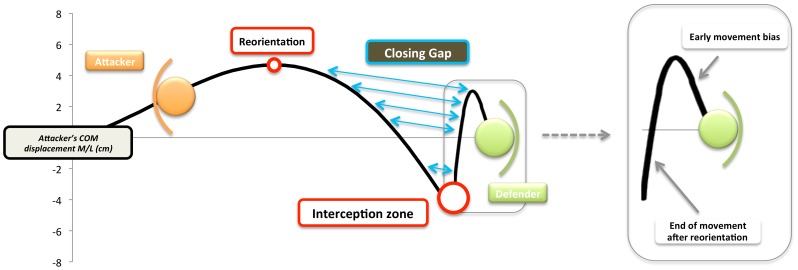
Relationship between the displacement of the attacker and a novice defender.This schematic diagram shows the reorientation point for the attacker and the distance gap that needs to be closed so that the defender can intercept the attacker (blue arrows). The interception zone shows where this took place. The panel on the right shows an early movement bias, that is a movement in the wrong direction caused by the deceptive movement of the attacker. The tau-coupling analysis looked at how the information embedded in the movement kinematics of the attacker from the point of reorientation to the interception zone (tau perception), influenced the way the defender moved to close the gap between them and the attacker (tau action).